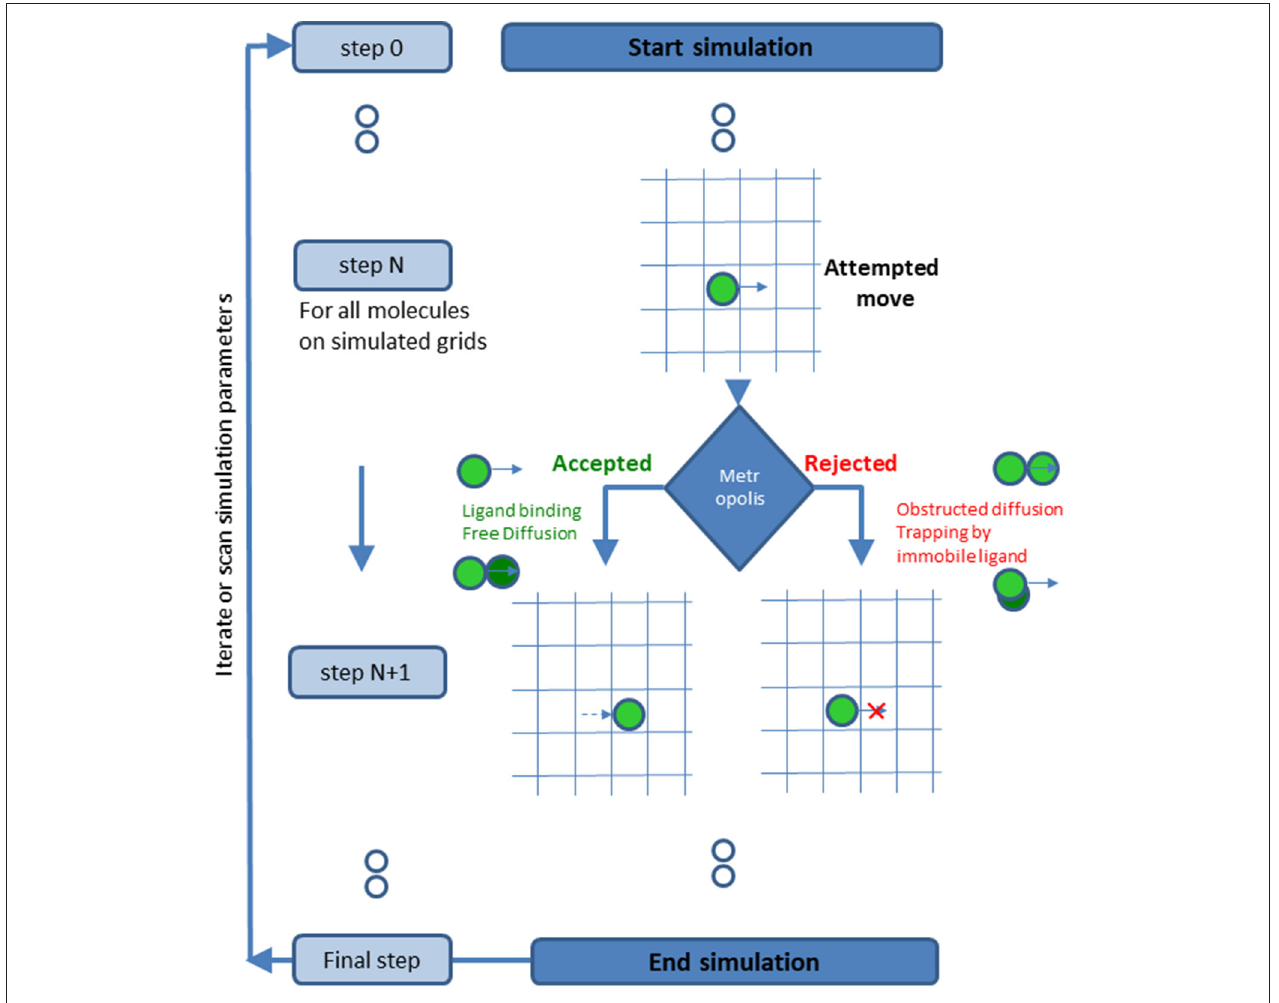
FIGURE 5 | A schematic description of the simulation process.